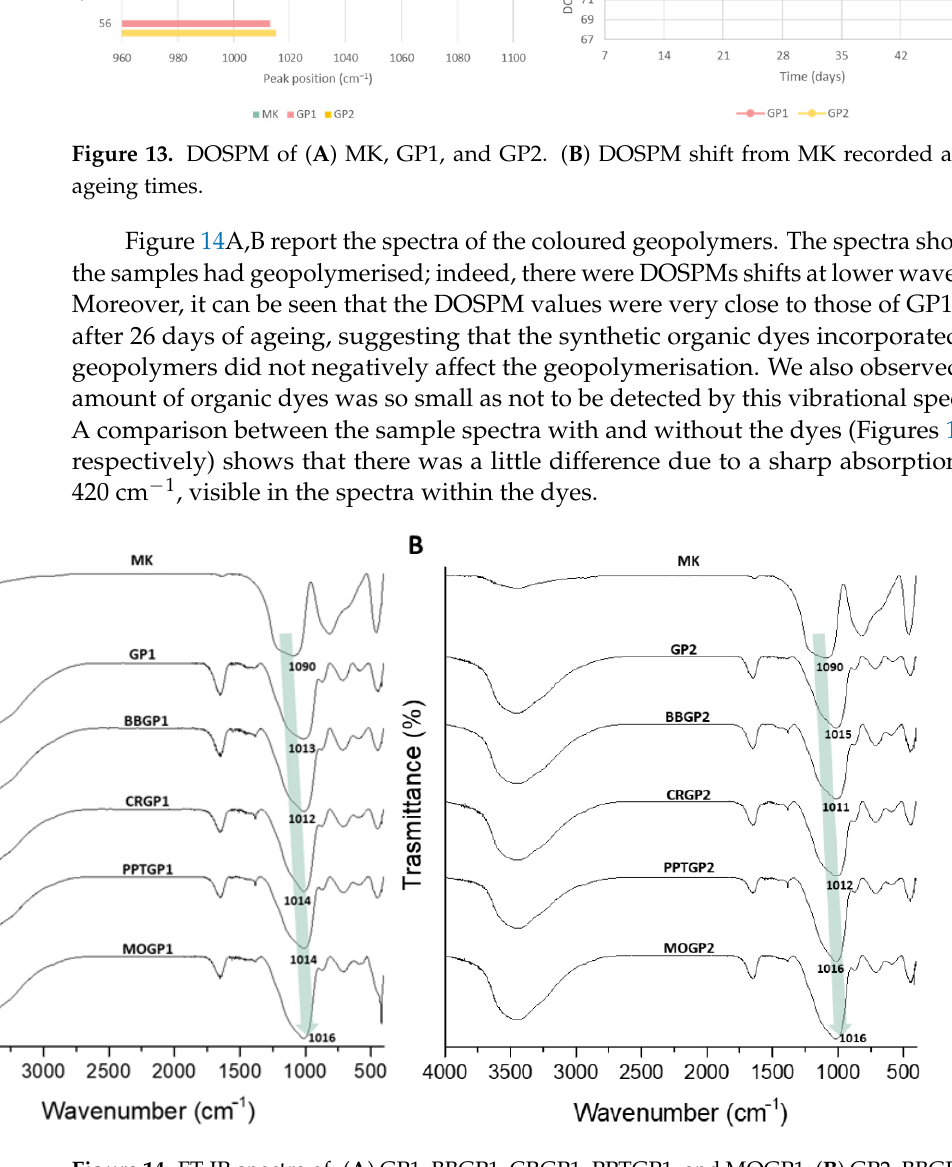
11 of 14 Figure 12. FT-IR spectra of ( A ) GP1 and ( B ) GP2 tested at different ageing times and compared with the MK spectrum. Figure 13A reports the DOSPM peak position of MK and GPs at different curing and